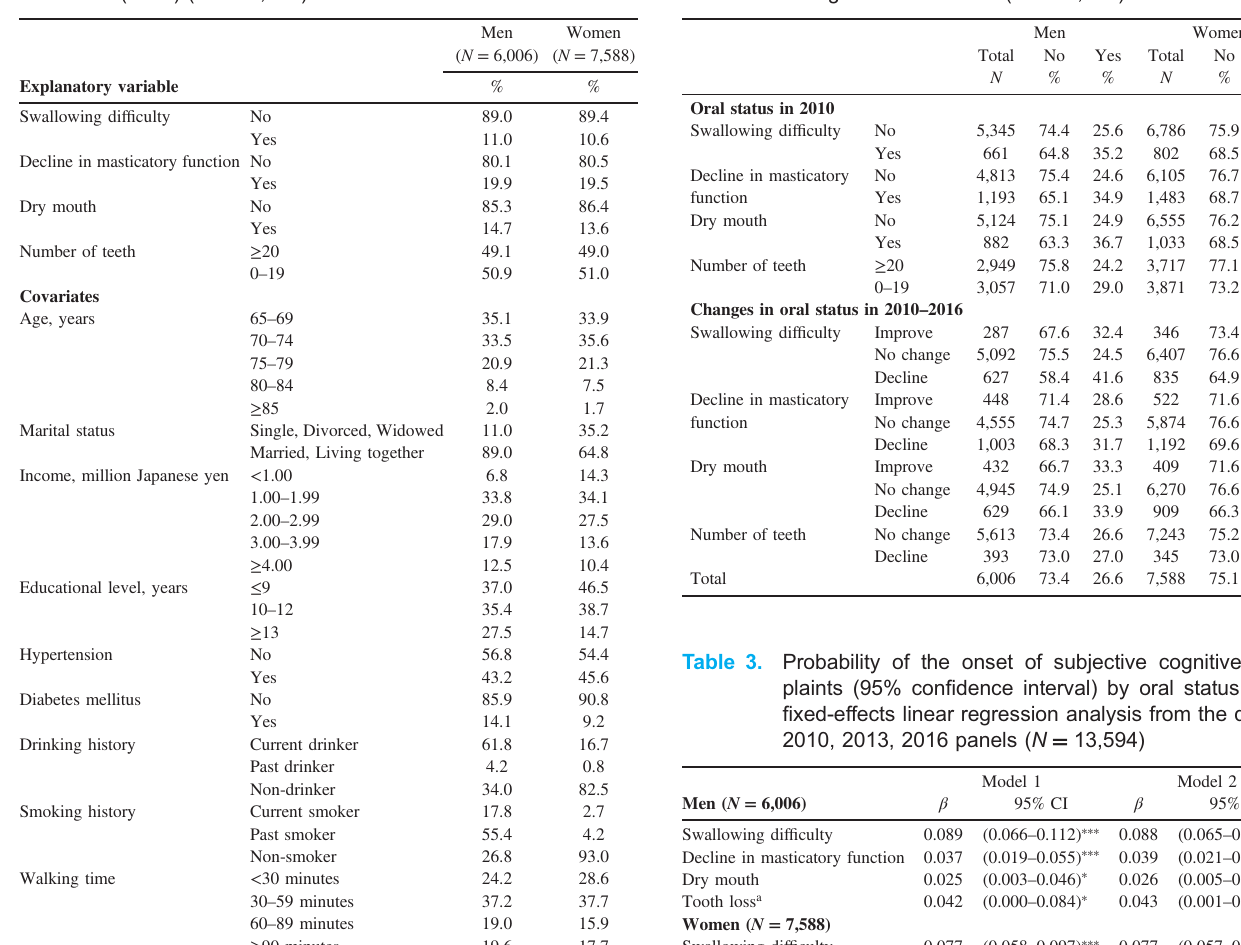
Table 1. Descriptive baseline characteristics of the participants who did not have any subjective cognitive complaint (2010) ( N = 13,594)